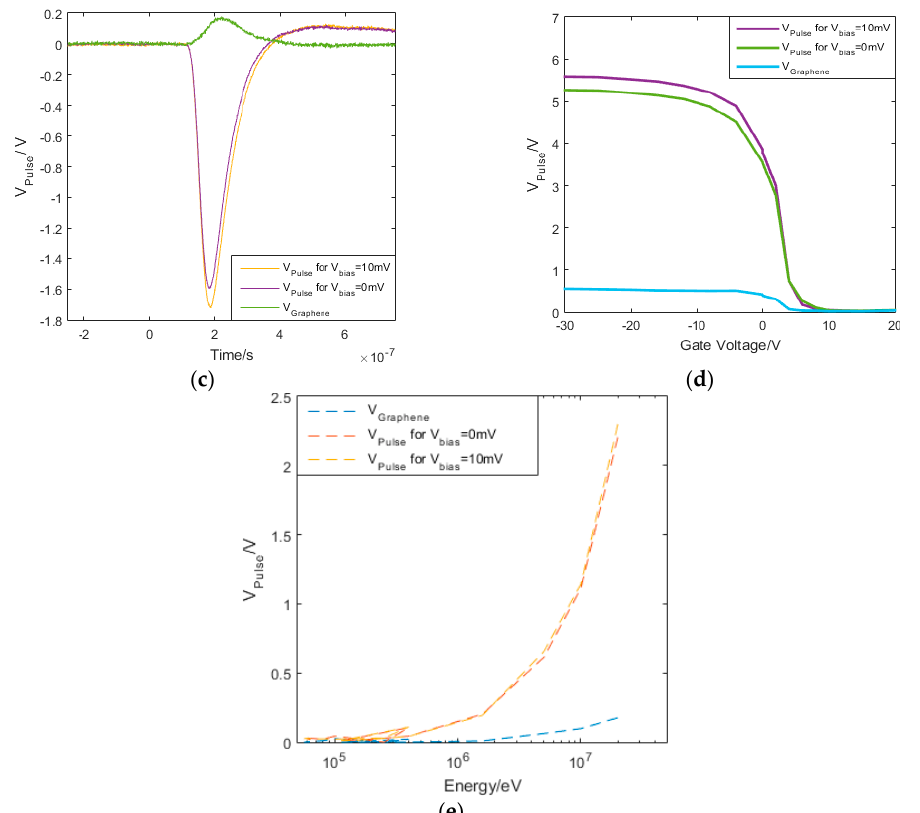
Figure 13. Showing ( a ) the exponential decay on the signal with increasing attenuation of the laser input; ( b ) the measured pulse energy collected in the absorber, indicating an energy sensitivity to ~100 keV; ( c ) the difference in the pulse with Vbias = 10 mV and 0 mV for a gate voltage of − 15 V showing a small peak attributed to the change in graphene resistance; ( d ) the magnitude of V Pulse for V bias = 10 mV and 0 mV and the signal from the graphene for increasing gate voltage, again showing the saturation described previously; and ( e ) the magnitude of V Pulse for different energies deposited in the absorber by attenuating the incident laser signal to indicate our detector’s energy sensitivity, for V bias = 10 mV and 0 mV and identifying the signal attributed to the graphene.